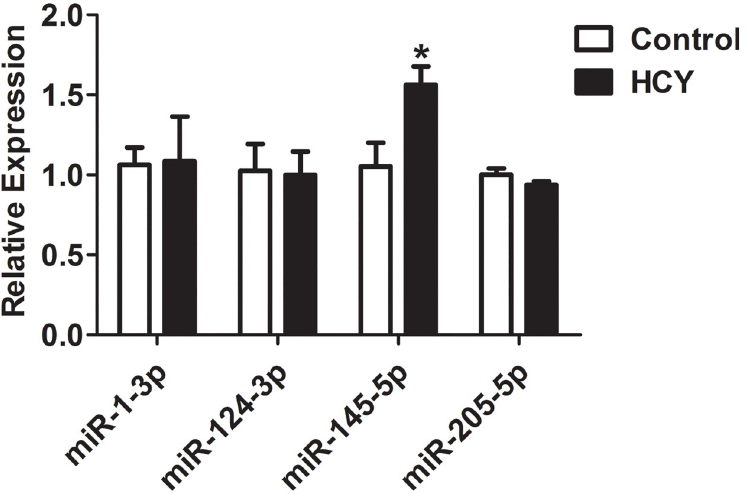
Fig 3. qRT-PCR analysis of miR-1-3p, miR-124-3p, miR-145-5p and miR-205-5p in Hcy-treated HUVECs. Only the miR-145-5p level increased significantly in the Hcy group compared with the control group. � P < 0.05 when compared with control